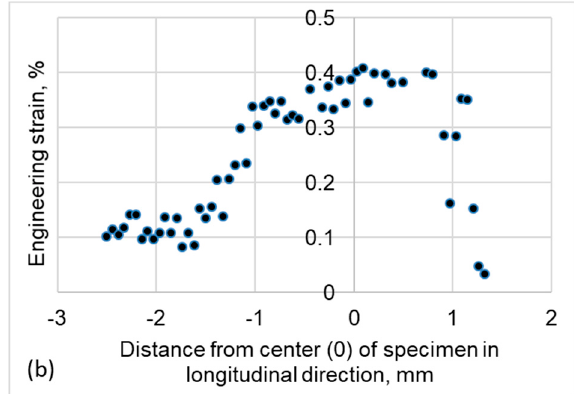
Figure 10. Strain evolutions calculated using the pictures captured during the tensile test at 571 °C and analyzed using the GOM Correlate software: ( a ) strain evolution at the center of the specimen as a function of test time, and ( b ) strain distribution within 5 mm distance of the center in the longitudinal direction.